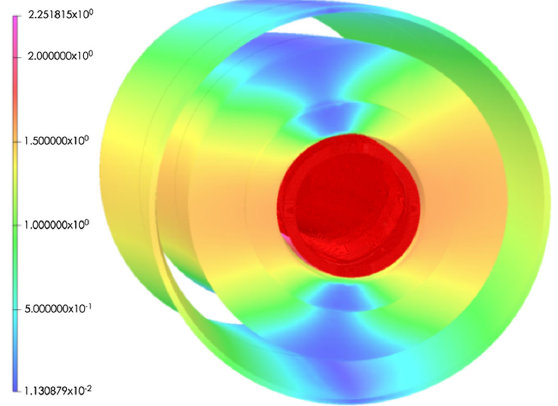
FIG. 14. Three-dimensional image of magnetic-flux density for the large-aperture magnet, as calculated by the three- dimensional electromagnetic field solver, OPERA-3D . The unit of the magnetic field, j B j , is Tesla. In the calculation, the coil currents of 231 and 200 A were applied for the dipole and quadrupole coils, respectively.